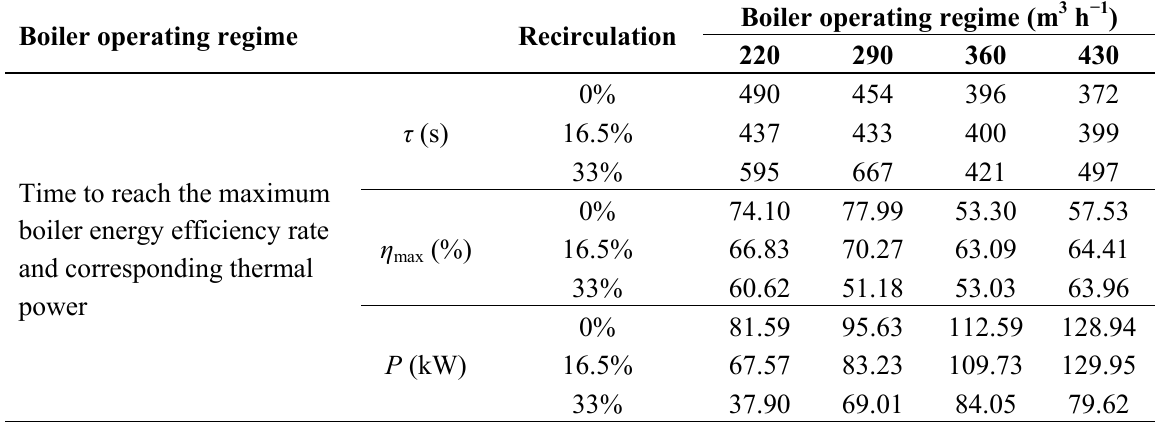
Table 7. Maximum boiler energy efficiency rate and corresponding boiler thermal